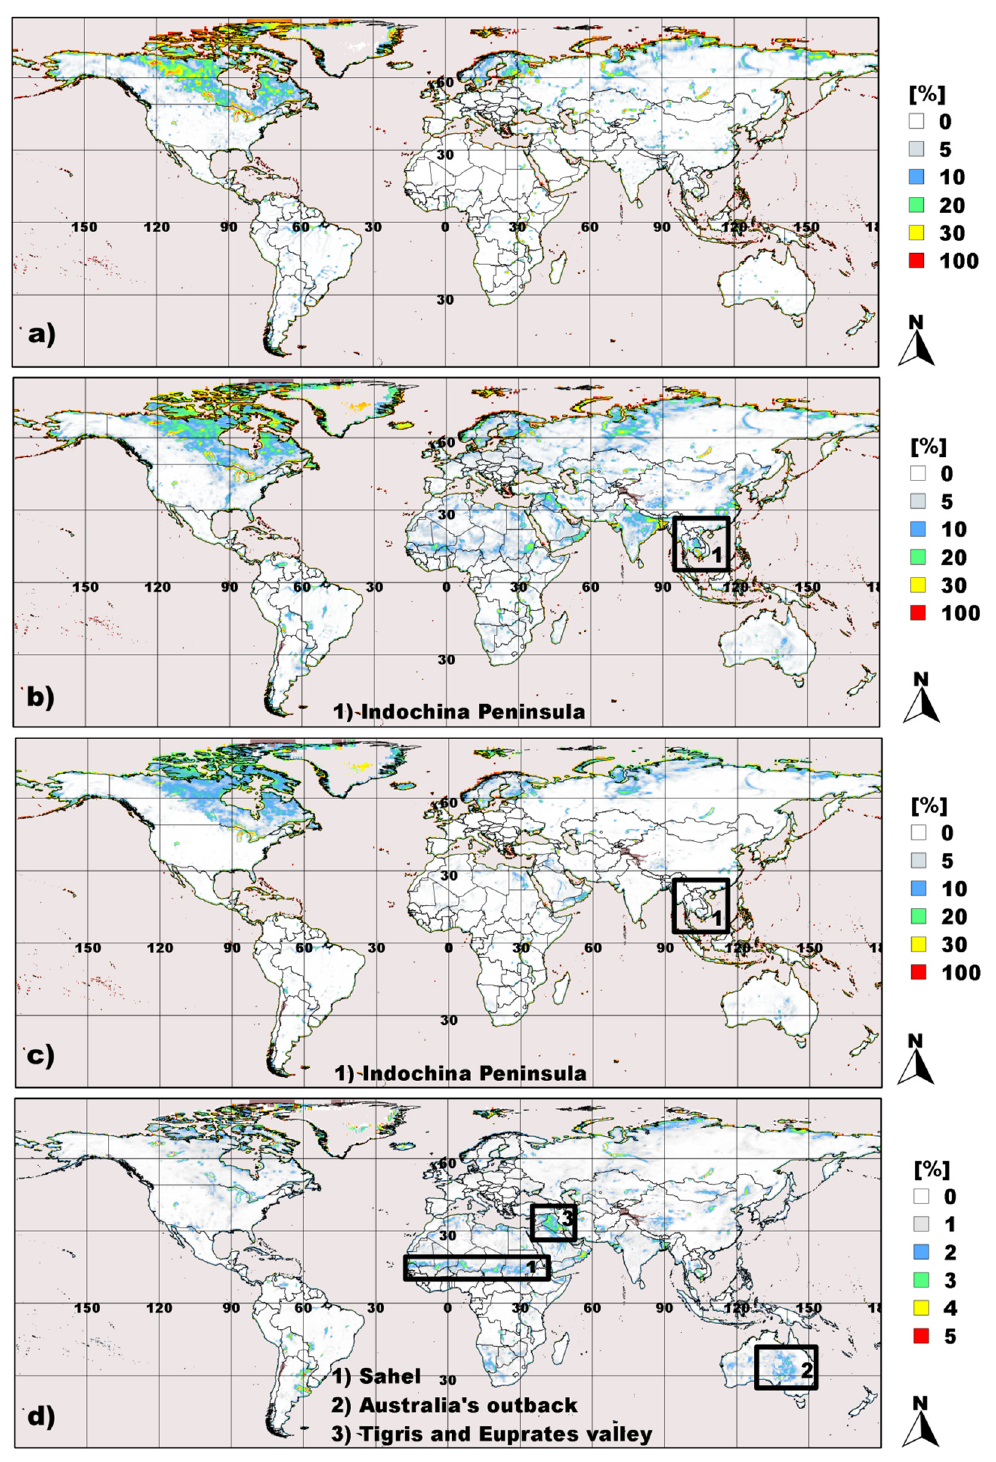
Figure 4. Global maps of fractional water (FW): ( a ) MOD44W FW; ( b – d ) the average annual maximum, minimum, and associated standard deviation of the annual means, respectively, of FW, as determined from combined v1-ERS (1992–1999) and v1-QSCAT (2000–2008) monthly means of FW over the global domain. Areas in light grey are outside of the domain, while areas in dark grey represent snow-covered regions. Actual figure color is a linear interpolation of the colors in the legend. Map projection same as Figure 2. Distance covered by one degree of latitude is approximately 111-km.